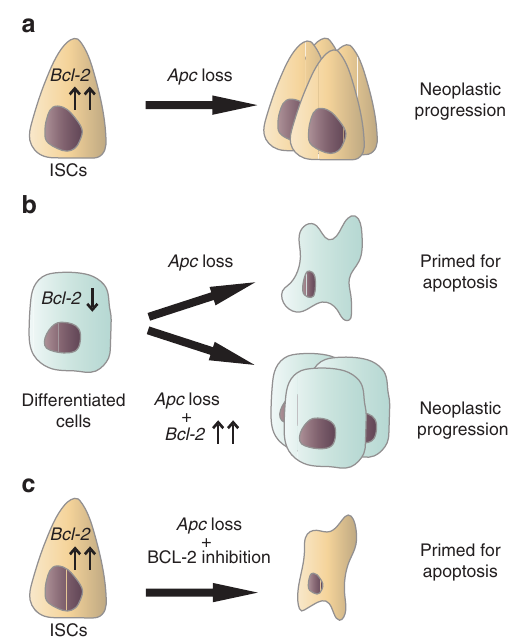
Figure 8 | Model of the differential response to Apc -loss dependent on Bcl-2 expression. ( a , b ) Apc -loss causes cellular stress which primes the Bcl-2 deficient differentiated cells to undergo apoptosis whereas ISCs are rescued by high Bcl-2 expression. As a result, only the ISC population is able to undergo malignant transformation upon Apc inactivation. However, when differentiated cells gain Bcl-2 expression, these cells are also able to efficiently transform ( b ). This suggests that Bcl-2 expression is an important prerequisite for intestinal epithelial cells to transform. ( c ) The survival of Apc depleted ISCs can be impaired by treatment with BCL-2 inhibitors and therefore we propose that BCL-2 could serve as an effective chemopreventive target for CRC